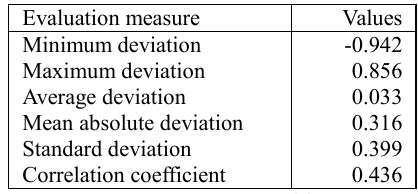
Table 2. Goodness of fit